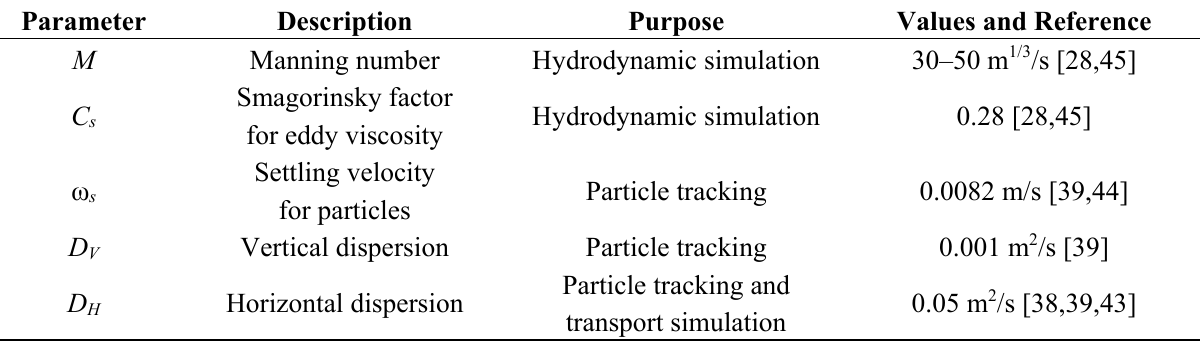
Table 1. Model parameters used for scenario